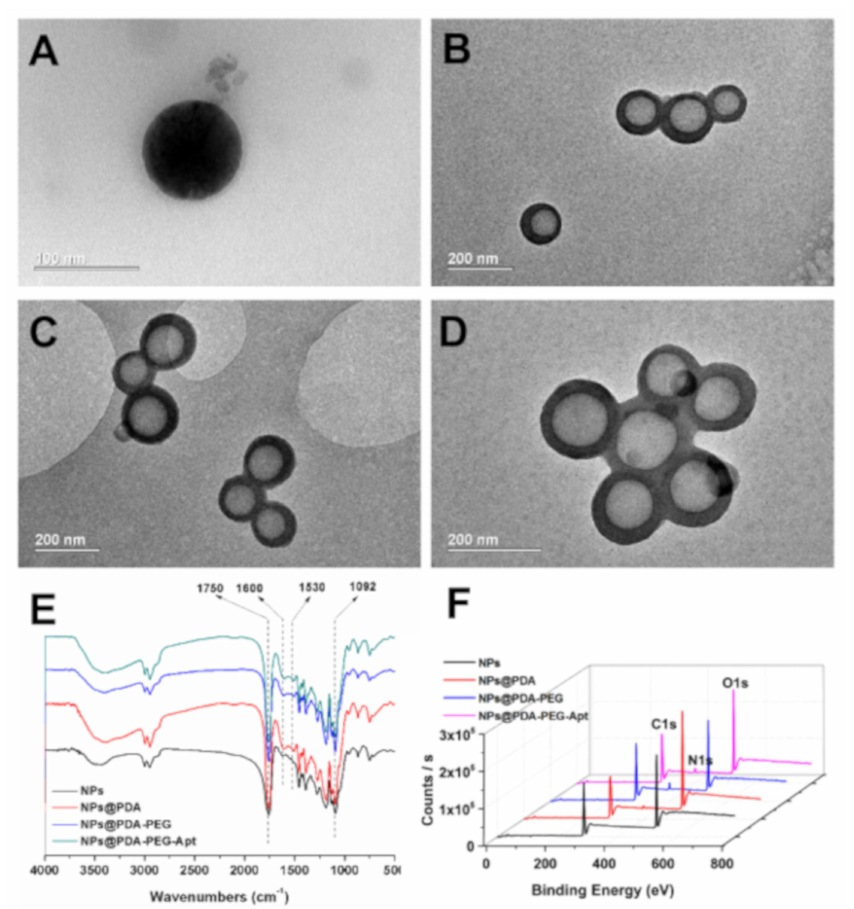
Figure 2. TEM images of ( A ) DTX / NPs, ( B ) DTX / NPs@PDA, ( C ) DTX / NPs@PDA-PEG-Apt and ( D ) DTX / NPs@PDA / DOX-PEG-Apt. ( E ) Fourier transform infrared (FT-IR) spectra of drug-free NPs. ( F ) X-ray photoelectron spectroscopy (XPS) wide scan spectra of drug-free